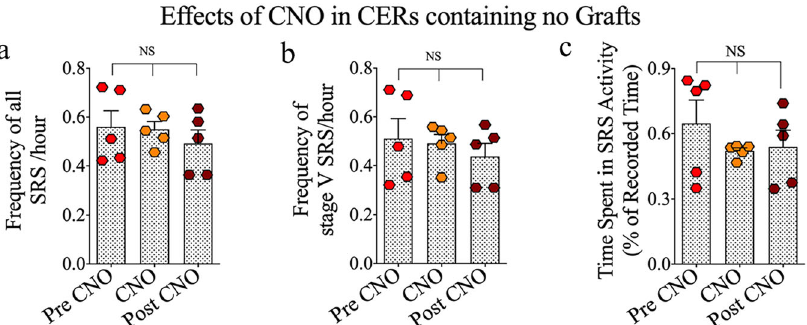
Fig. 4 Effects of clozapine-N-oxide (CNO) on spontaneous recurrent seizure (SRS) activity in chronically epileptic rats receiving no grafts. The bar charts a – c compare all SRS and stage V SRS frequencies and times spent in SRS activity (% of recorded time) during the pre-CNO, CNO, and post-CNO periods in CERs receiving no grafts. Values in bar charts are presented as mean ± S.E.M. NS, non-signi fi cant (one-way ANOVA with Newman – Keuls multiple comparisons